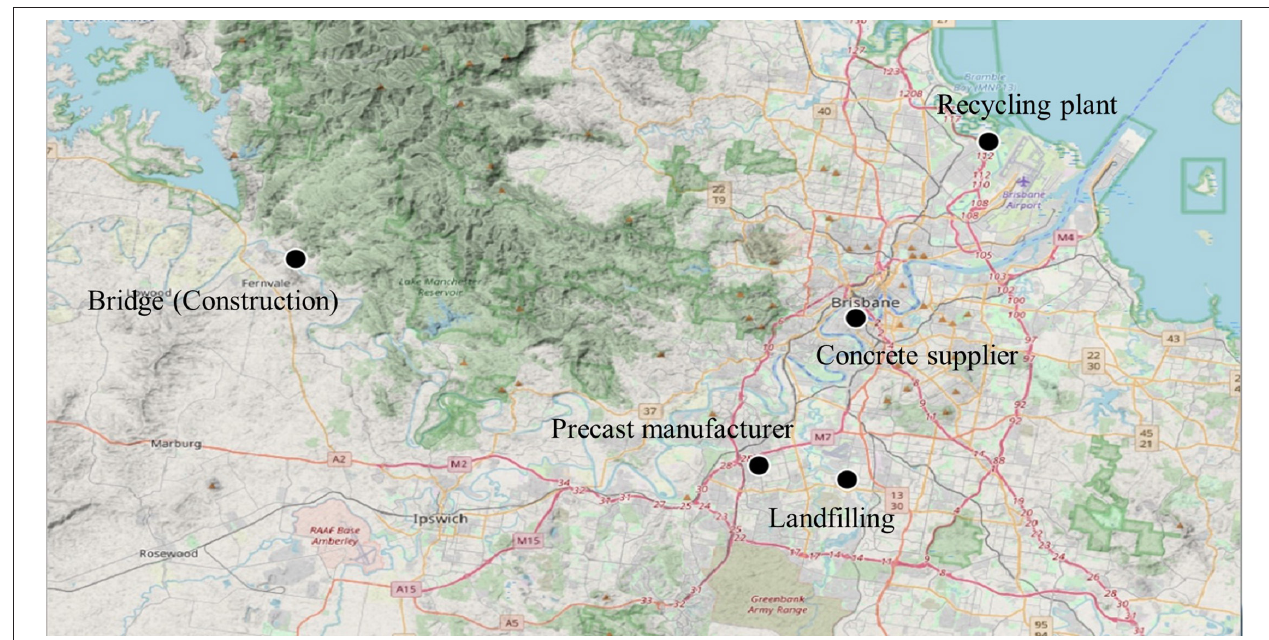
FIGURE 3 | Location of the supply chain stakeholders.